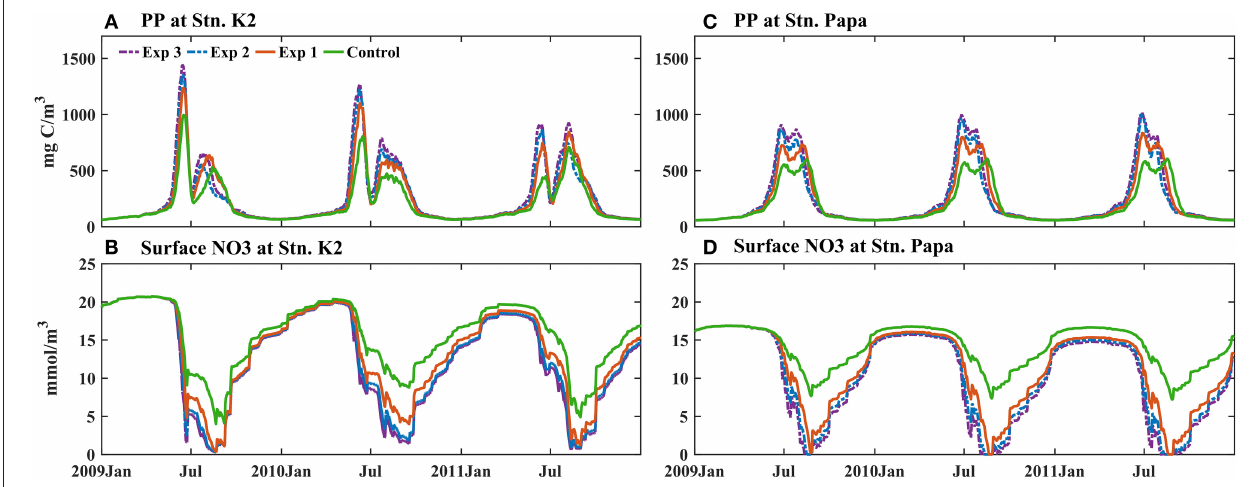
FIGURE 12 | Modeled (A,C) primary production integrated over the upper 150m (PP, mg C/m 2 /day) and (B,D) surface nitrate (SNO 3 , mmol/m 3 ) in different experiments forced by two (Exp 1), three (Exp 2), and four times (Exp 3) as much atmospherically deposited Fe as in the control run at (A,B) Stn. K2 and (C,D) Stn. Papa after